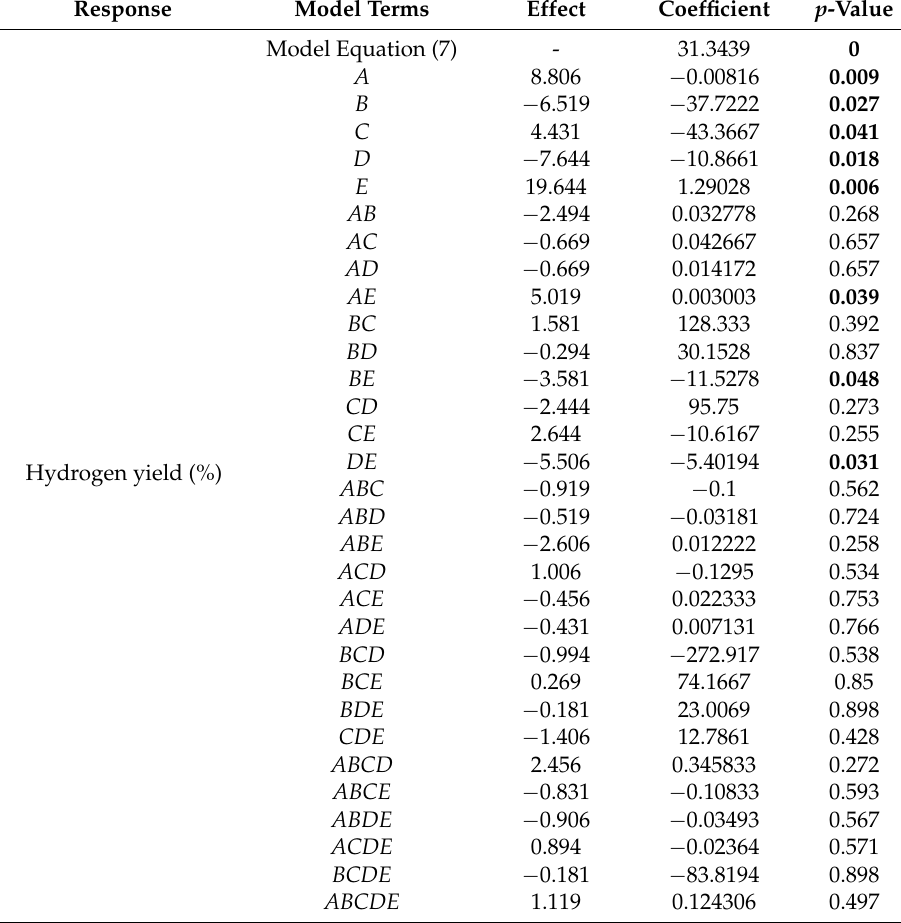
Table 4. Analysis of the regression coefficient of the initial model for hydrogen yield ( Y 2